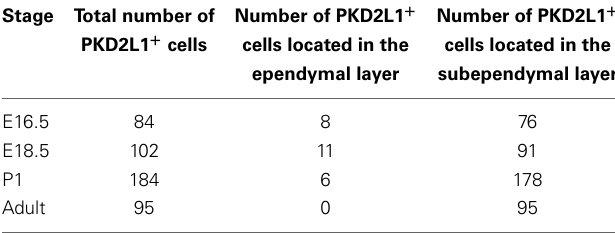
Table 1 | Distribution of PKD2L1 + cells based on the location of their soma relative to the ependyma in the mouse spinal